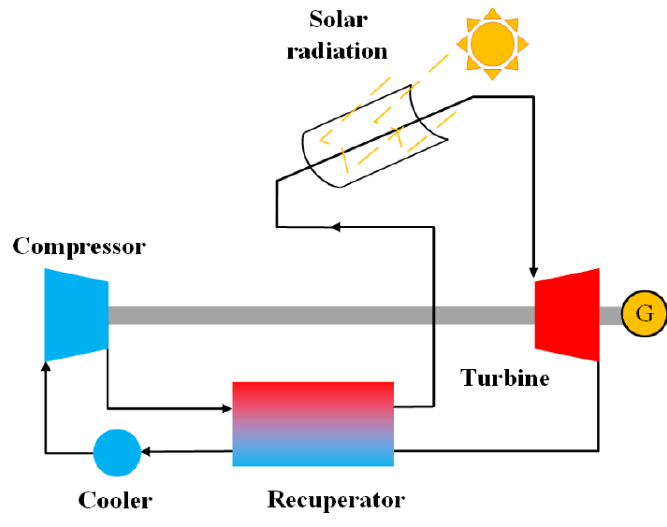
Figure 1. Configuration of the simple recuperated cycle.